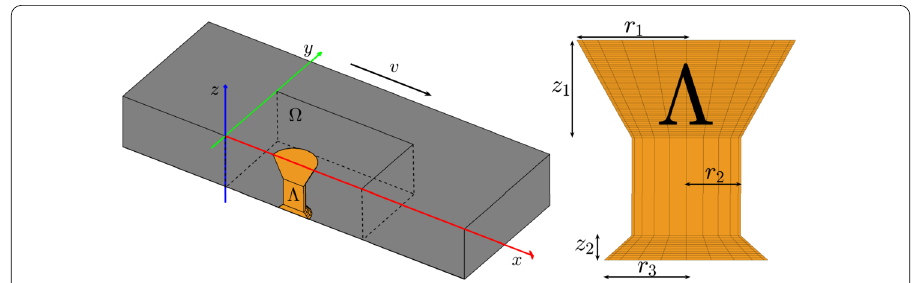
Figure 1 Half of steel plate and flame